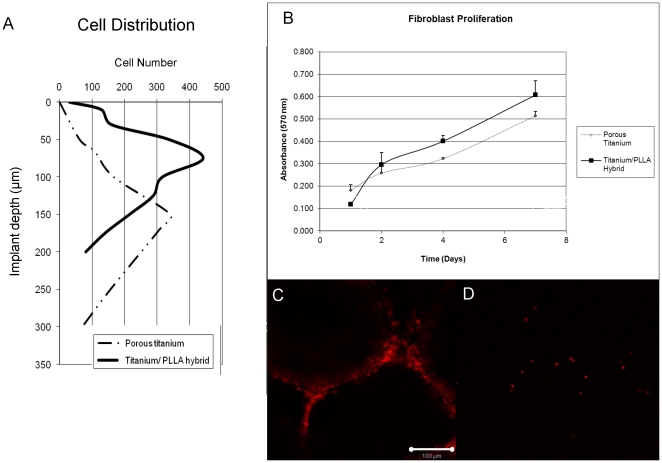
3T3 proliferation and the ability to reach to the other face of the implant.a) Depth of cell movement in Titanium only and Titanium/PLLA hybrids, cells moved considerably deeper in titanium only implants. The point were there was a significant drop in the signal (cell number) notified the final depth; b) MTT assay results for 3T3 proliferation: overall cell number was higher in PLLA/titanium hybrids due to decreased migration and the availability of more niches to proliferate; c) Confocal images of the front surfaces of the implants. A significant number of cells has reached the face of titanium only implants after 7 days of culture d) whereas only occasional cells can be observed in the case of Titanium/PLLA hybrids.